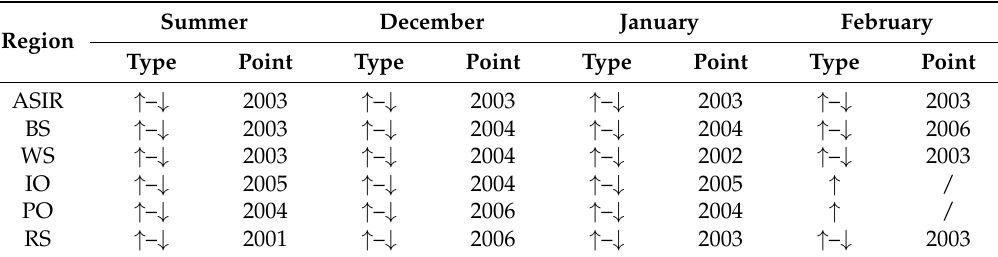
Table 9. As in Table 5 but for